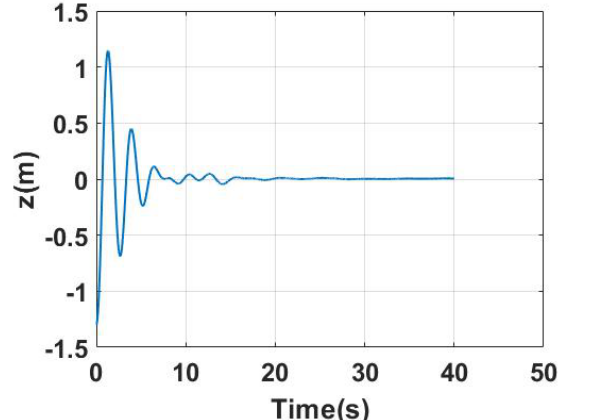
Figure 9. Heave decay